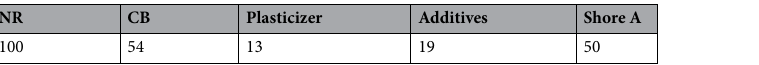
Table 1. The mix formulation in parts per hundred rubber by weight (phr) and Shore A hardness of carbon- black-filled natural rubber